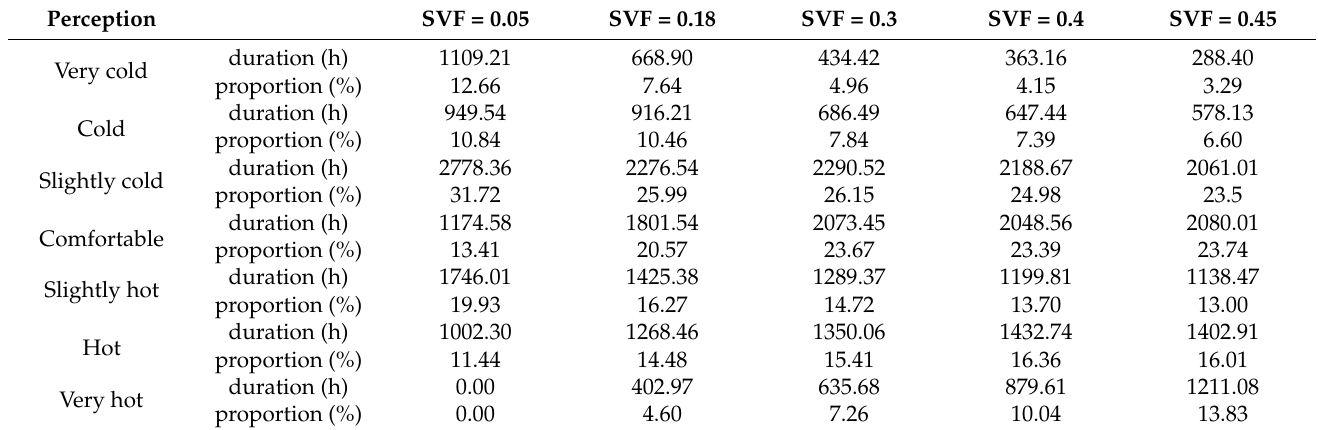
Table 5. Proportion and duration of indoor thermal perception for 5 SVF